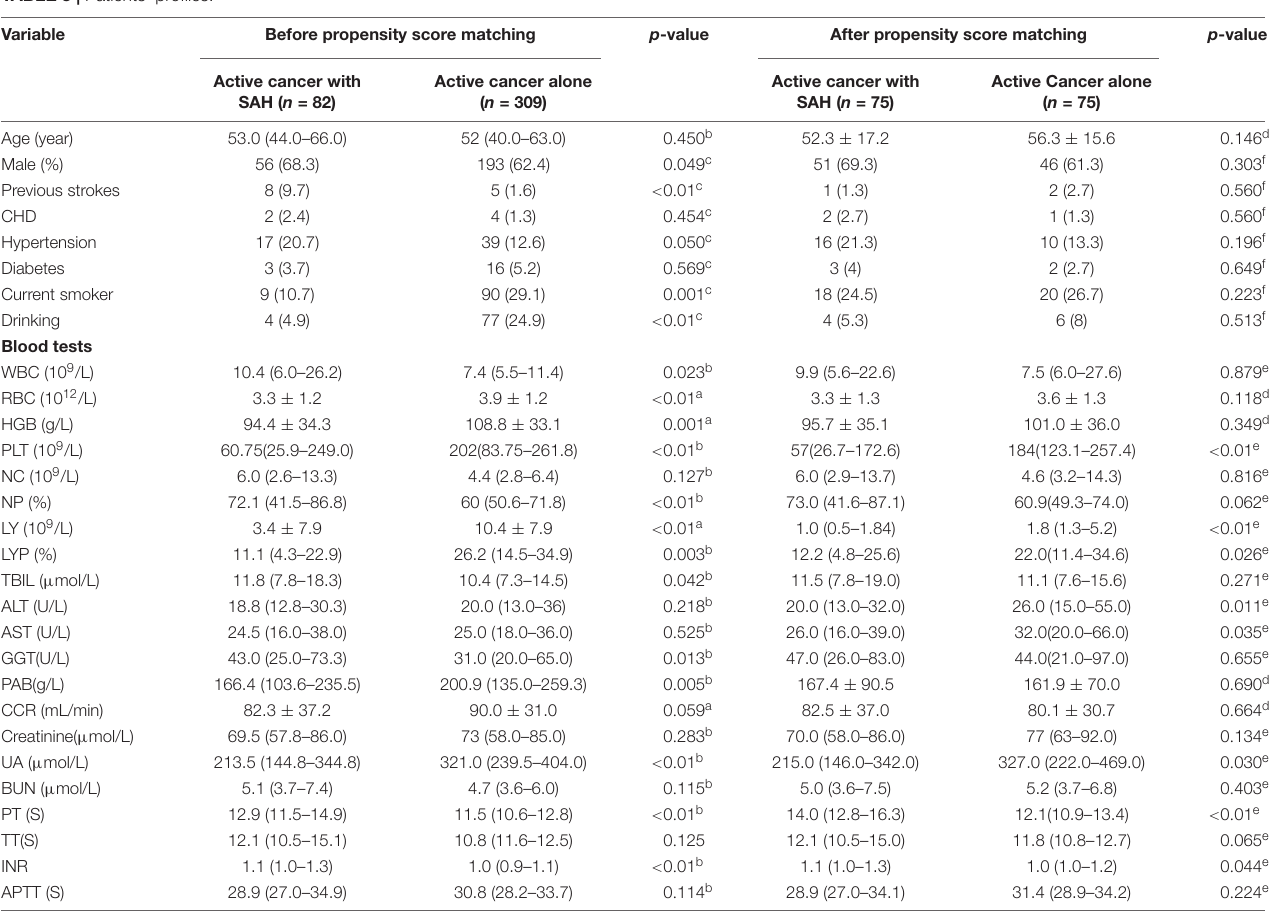
TABLE 3 | Patients’